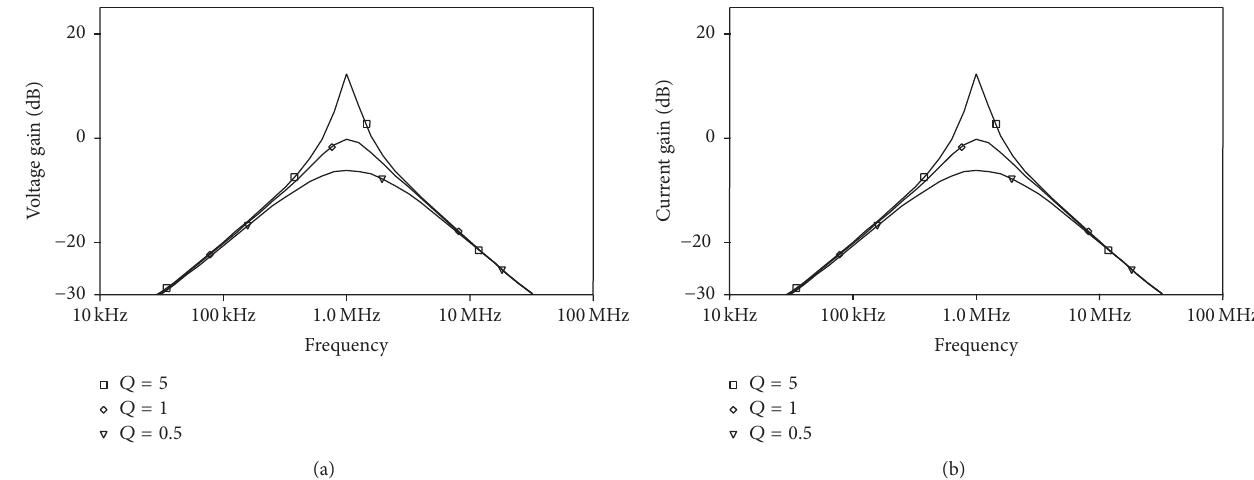
Figure 9: BP responses for 𝑄 0 = 0.5 , 1, and 5 with 𝑓 0 = 1 MHz for (a) VM and (b) CM topology.